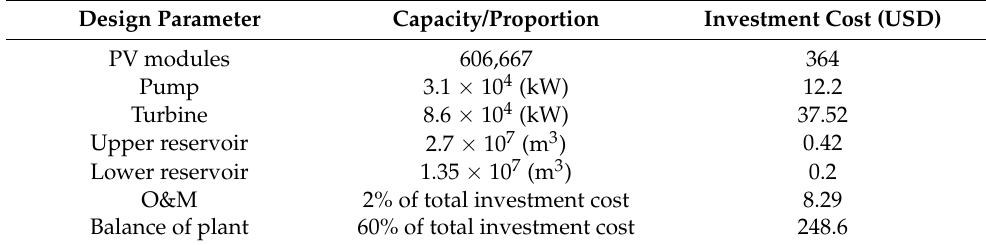
Table 5. Selected design investment costs.